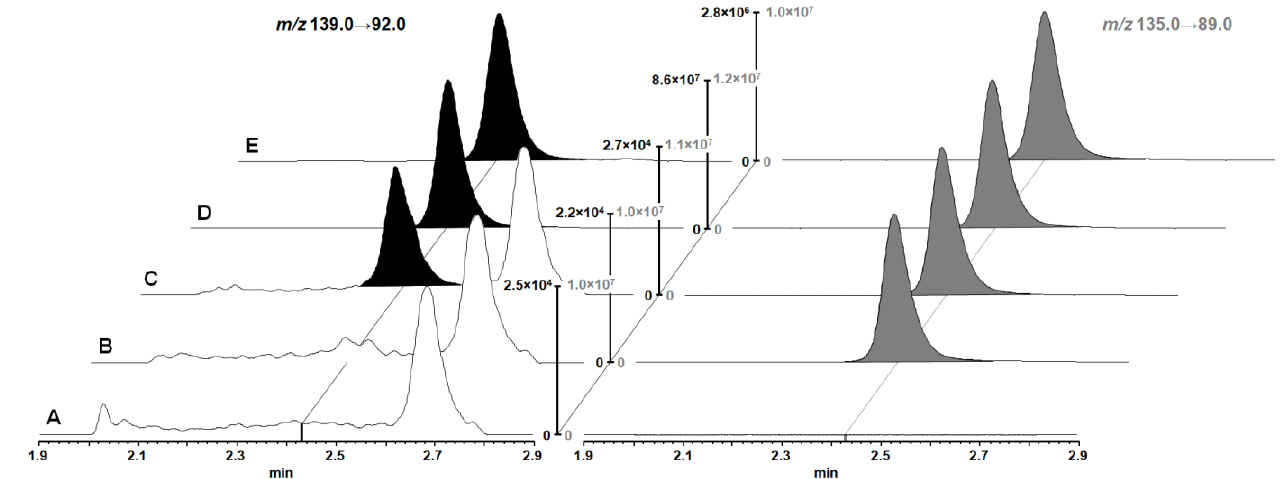
Figure 2. Chromatograms of [ 13 C 6 , 15 N]-L-leucine and IS [ 2 H 3 ]-L-leucine in cell lysates. The monitored [ 13 C 6 , 15 N]-L-leucine transition is shown on the left in black, and the internal standard (IS) transition is shown on the right in grey. ( A ) Blank sample, ( B ) blank lysate with added IS, ( C ) sample at LLOQ concentration, ( D ) sample at mid QC concentration, ( E ) intracellular [ 13 C 6 , 15 N]-L-leucine concentration after incubation with 10 μM [ 13 C 6 , 15 N]-L-leucine and 100 µM JPH203 for 10 min (quantified [ 13 C 6 , 15 N]-L-leucine concentration: 15.0 ng/mL). Intensities were normalized to the highest signal in the respective run, with the exception of the IS transition of the blank sample, which was normalized to the intensity of the blank sample with added IS.